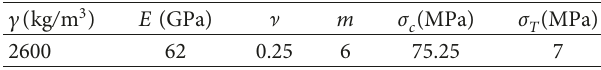
Figure 8: The complete stress-strain curve of the rhyodacite tuff tested in rock mechanics laboratory [24]. Table 2: Mechanical parameters used as input data.